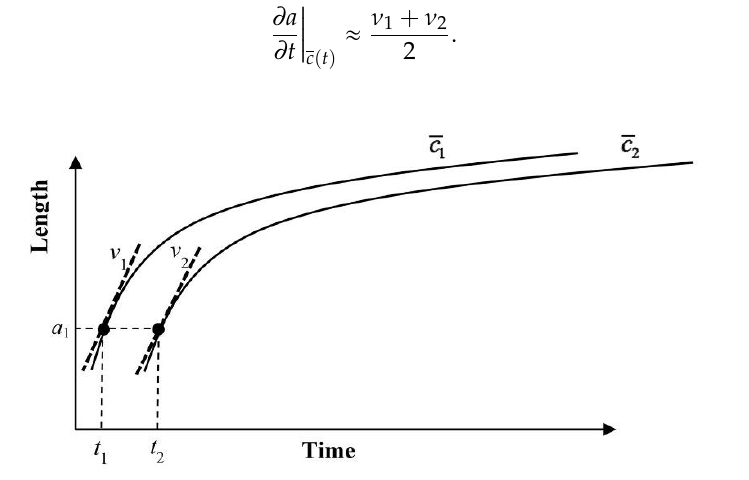
Figure 4. Schematic of the time discretization technique evaluating the interface velocity in the finite system.